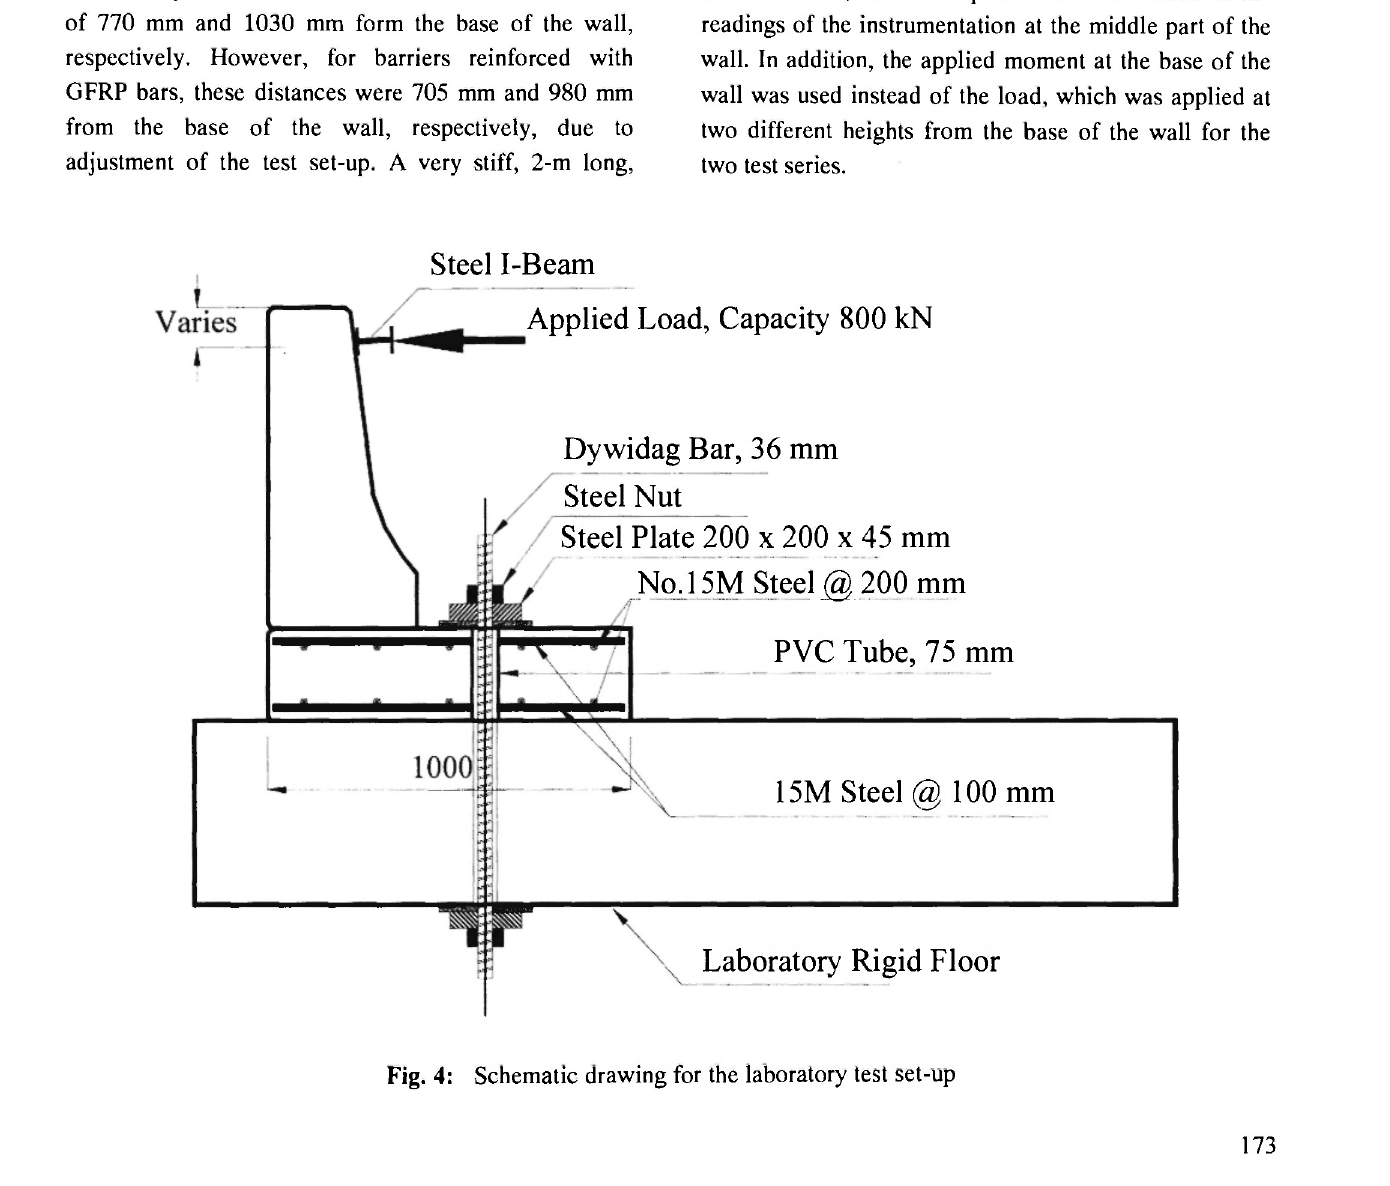
Fig. 4: Schematic drawing for the laboratory test